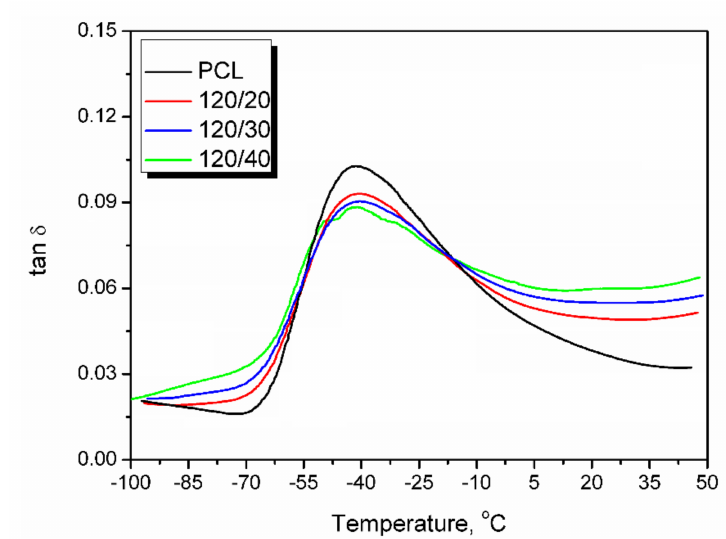
Figure 10. Temperature plot of tan δ for composites filled with BSG modified at 120 ◦